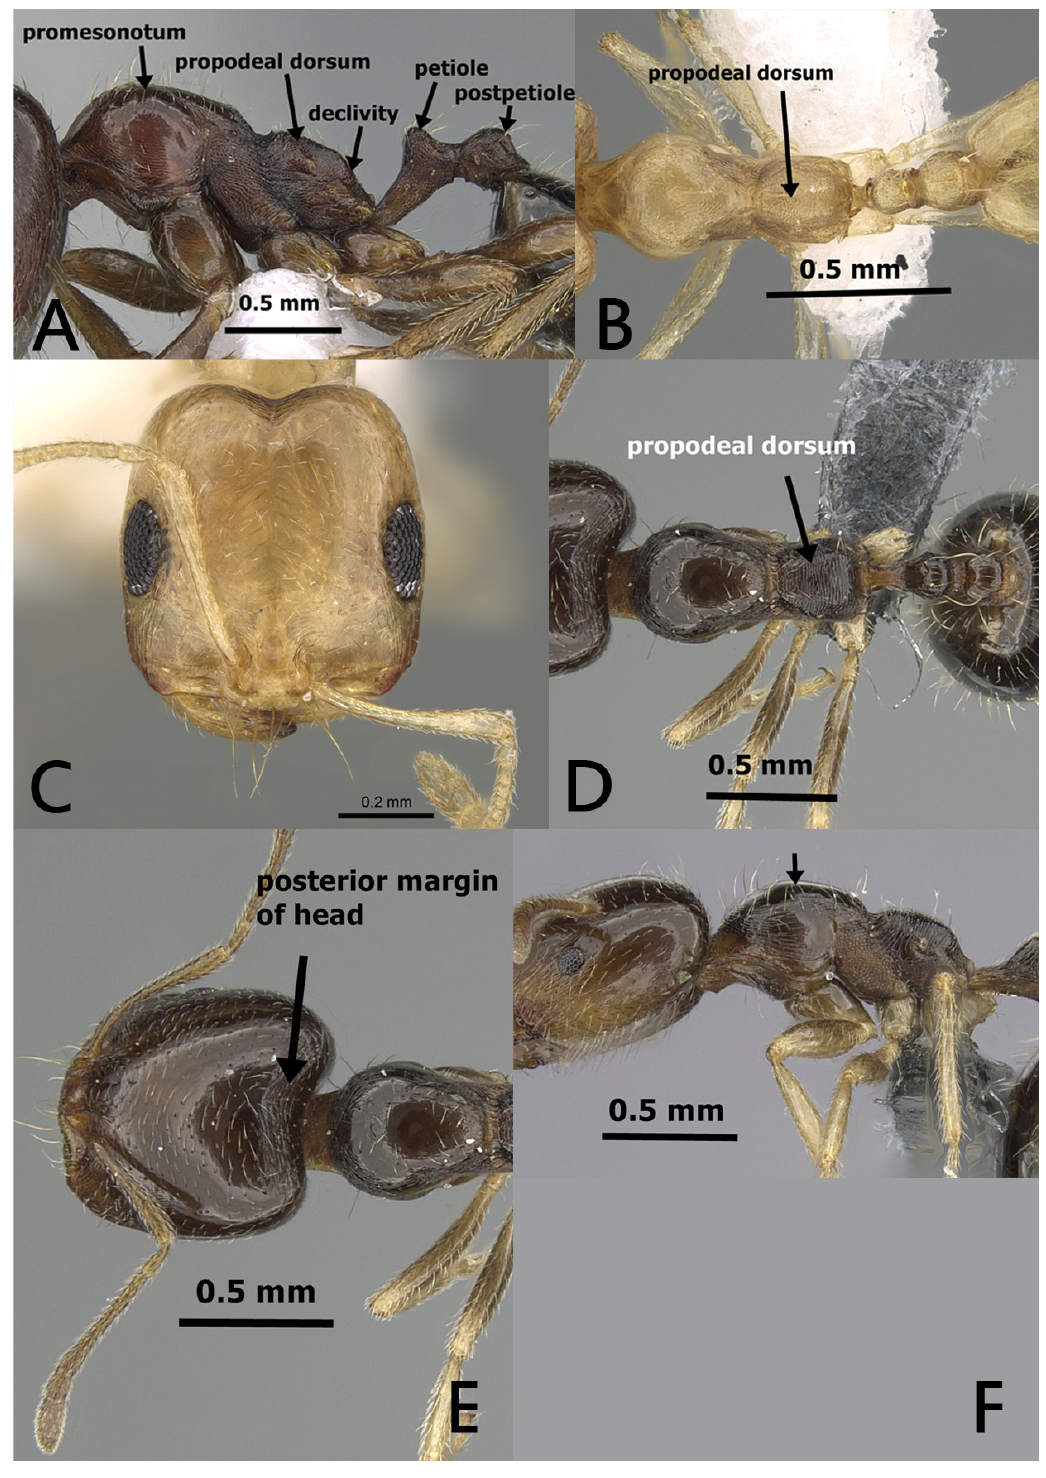
Fig. 3. A . Trichomyrmex perplexus (Radchenko, 1997), mesosoma, petiole and postpetiole in profile. B . T. shakeri sp. nov., mesosoma in dorsal view showing propodeum. C . T. shakeri sp. nov., head in full-face view. D . T. mayri (Forel, 1902), mesosoma in dorsal view showing propodeum. E . T. mayri , showing posterior margin of head in dorsal view. F . T. mayri , mesosoma in